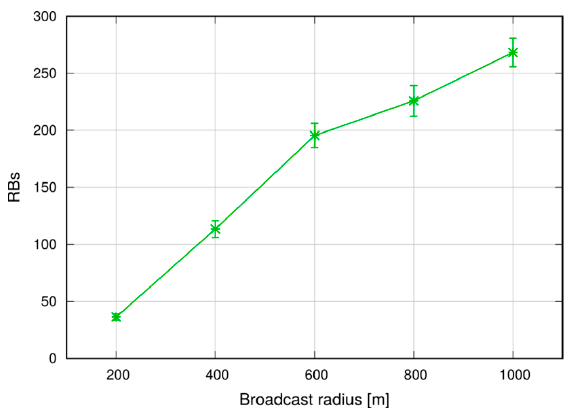
Figure 31. Allocated RBs per broadcast.